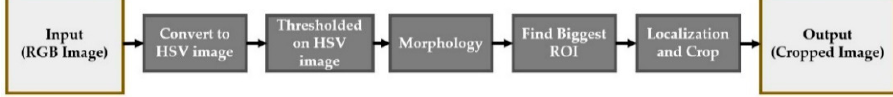
Figure 7. ROI extraction based on HSV color.